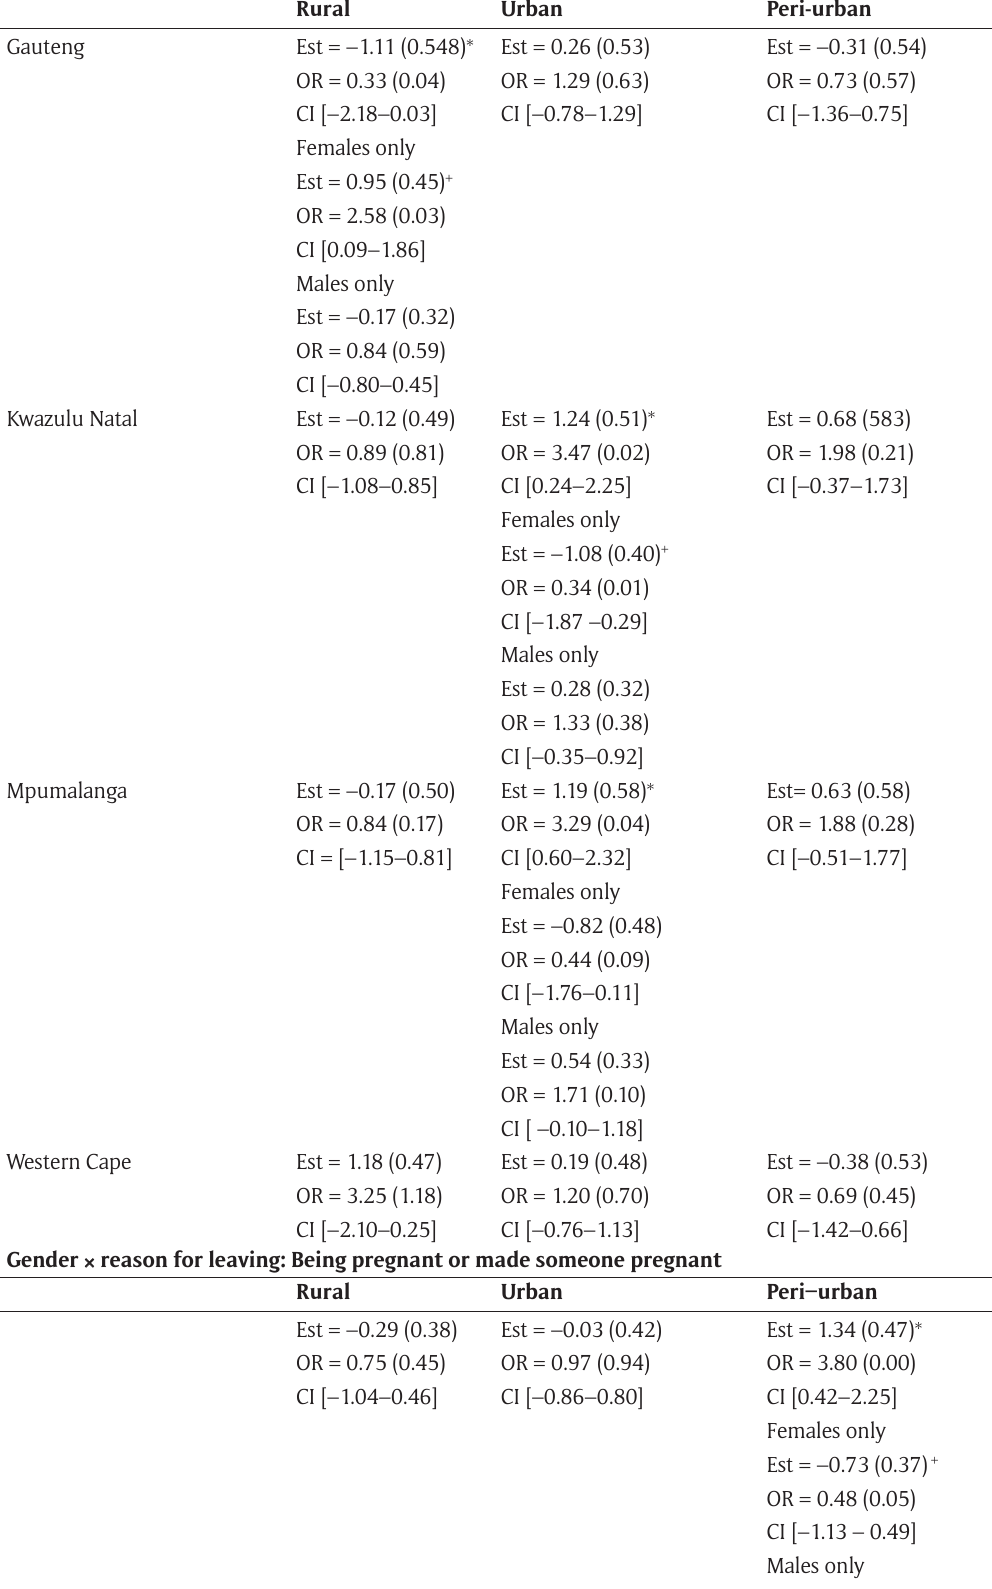
Table 3: Simple effects analyses for interaction effects models with gender as moderator. Gender × reasons for leaving: not enough money to pay for school